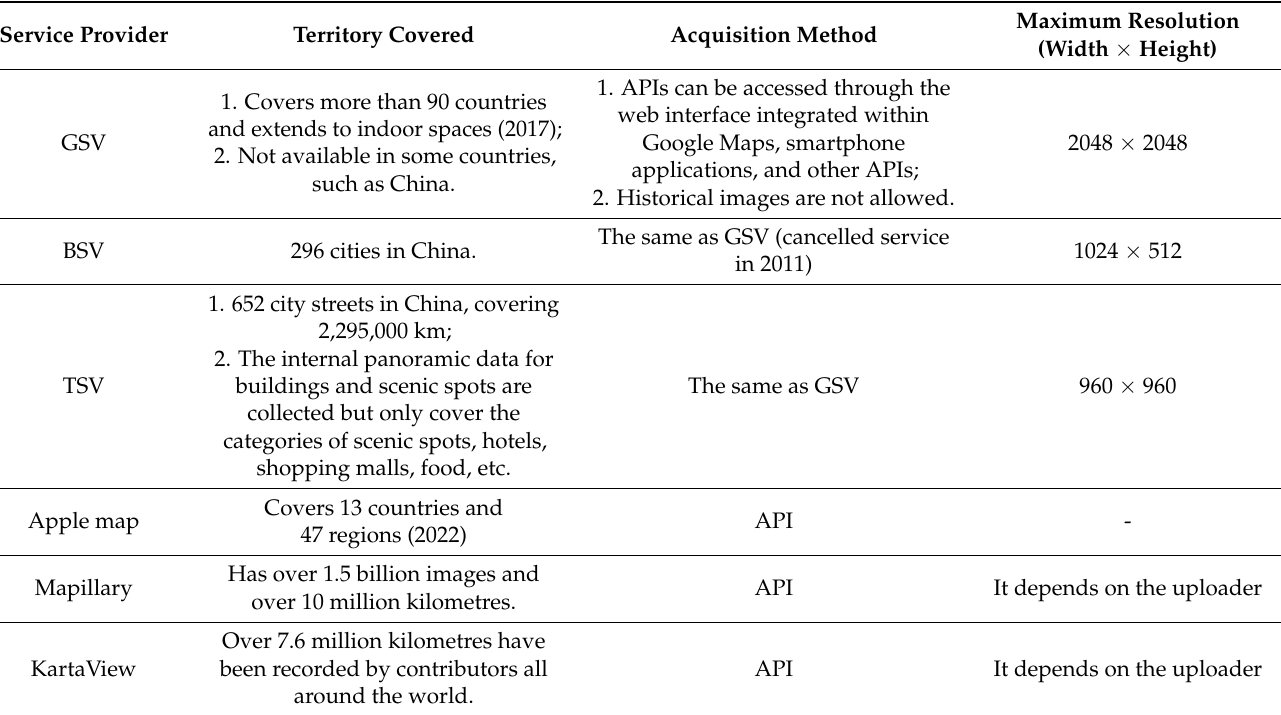
Table 1. Overview of the major service providers of